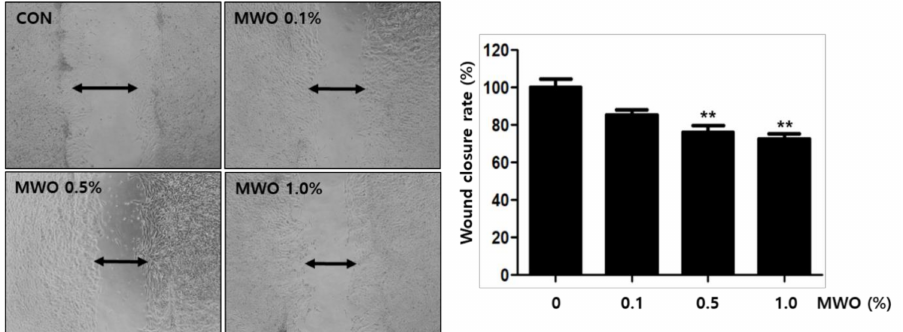
Figure 3. Effect of MWO on migration of fibroblast cells in a wound scratch assay. The culture well was fully filled with fibroblast cells. Wound gaps were then created by scratching with a scraper. The cells were treated with the indicated concentration of MWO for 24 h. The migration of fibroblast cells was observed and photographed with a Nikon light microscope. The quantitative evaluation of wound closure in the wound scratch assay was measured by the distance between the two front lines with the majority of migrated fibroblast cells. The values are shown as means ± SD. ** p < 0.01 compared to the control.